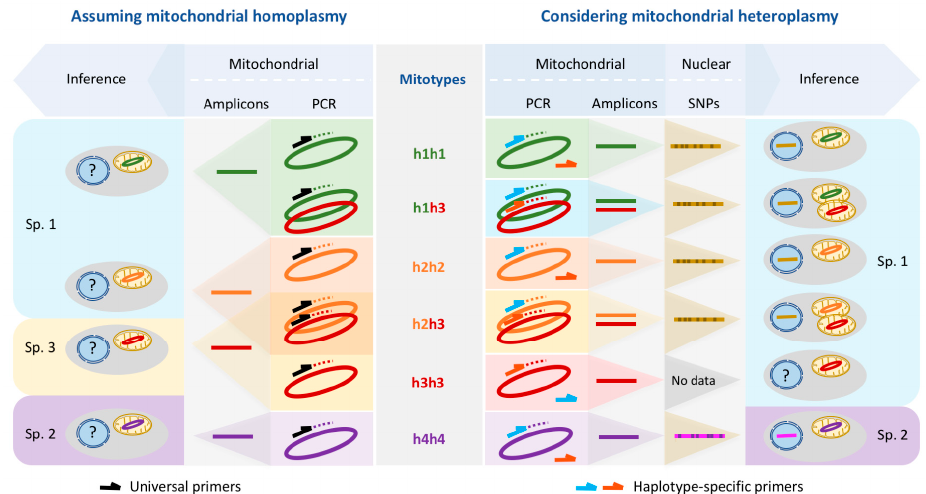
Figure 5. The amplification bias of Folmer primers and a standard barcoding analysis assuming strictly clonal inheritance of mitochondria leads to an overestimate of inferred species numbers (left half) in comparison to haplotype-specific primers and the inclusion of nuclear SNP data (right half). Note that amplifying h2h3 individuals using Folmer primers leads to the amplification of either h2 or h3, but never both. Although no nuclear SNP data are available for the single h3h3 individual, we include it in species 1 here on the grounds that h3 mitochondria are associated with nuclear SNP patterns that characterize species 1 (see h1h3 and h2h3).